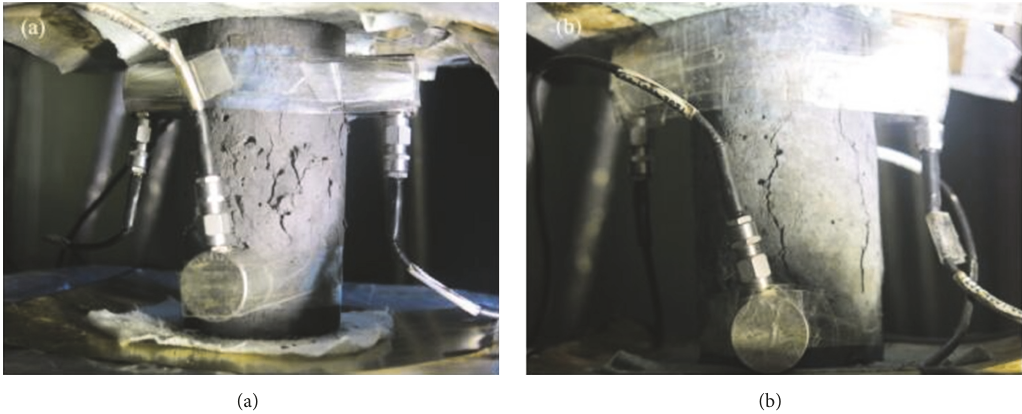
Figure 9: Photos of CGB samples after failure: (a) CGB sample at 1 day and (b) CGB sample at 7 days.